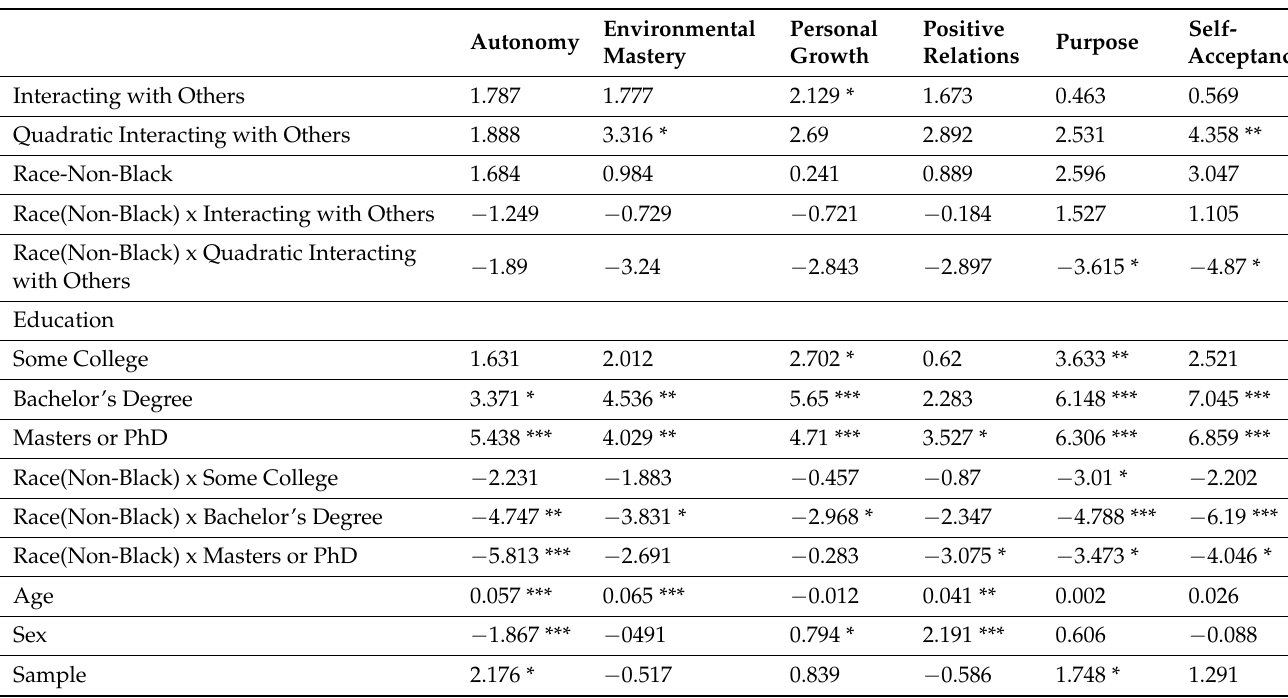
Table A4. Interacting with others and Well-being.